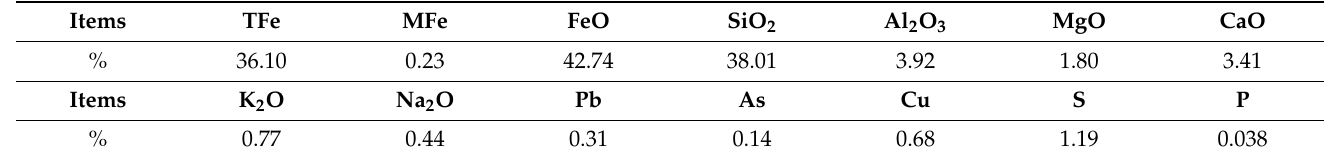
Table 1. Chemical compositions of copper slag